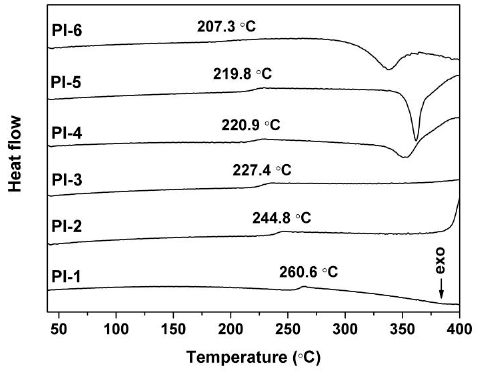
Figure 8. DSC plots of PI films.